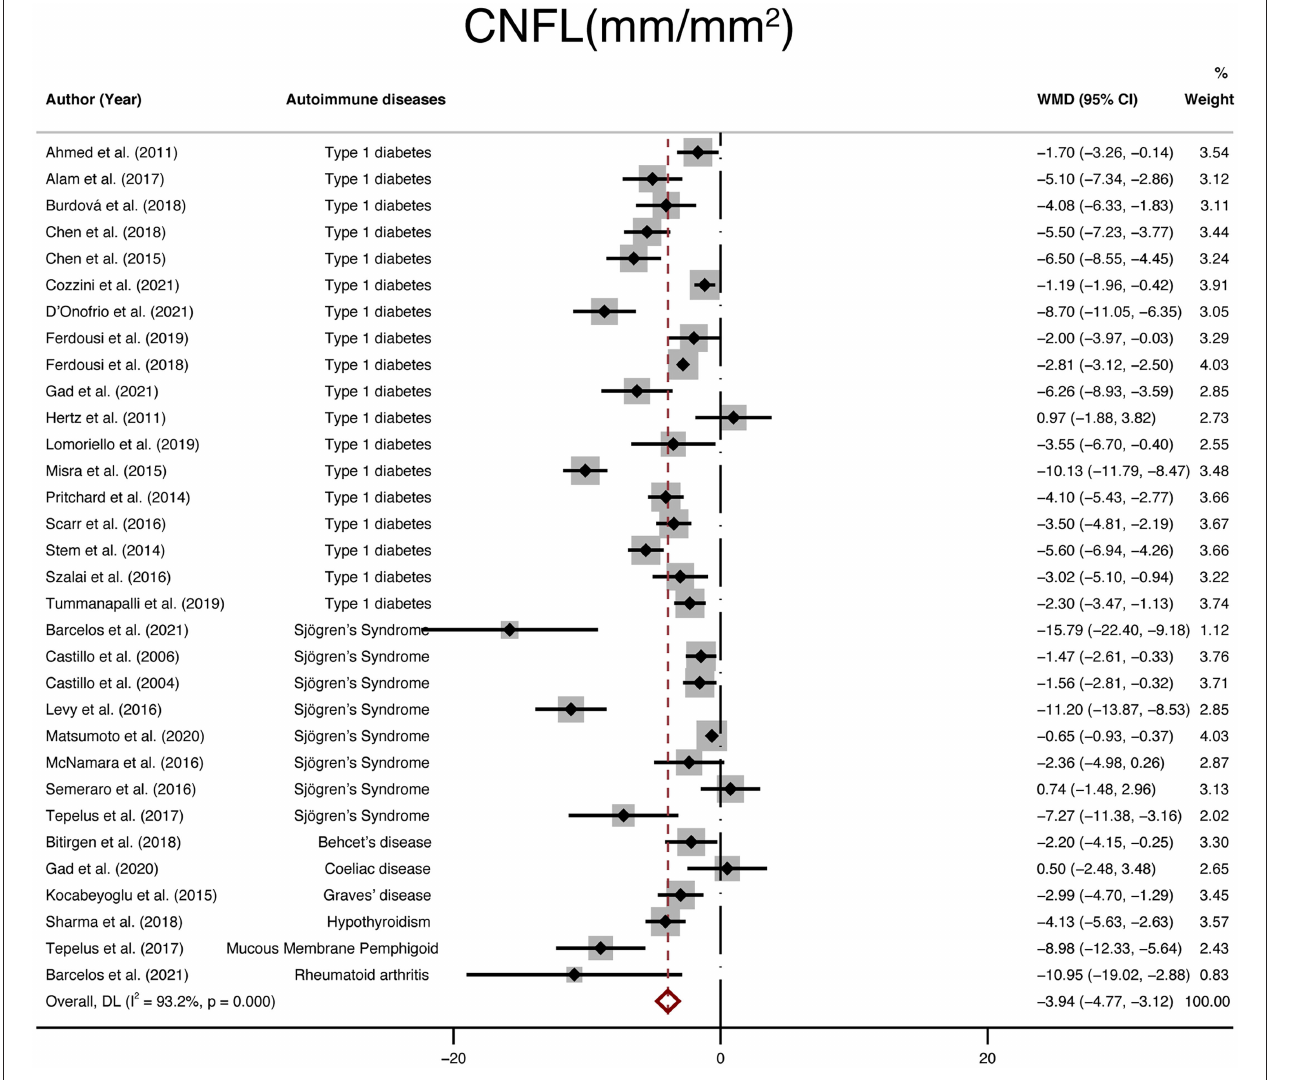
FIGURE 4 | Forest plot of the WMD of CNFL between the NNAI group and the control group. WMD, weighted mean difference; CI, confidence interval; CNFL, corneal nerve fiber length; NNAI, non-neurological autoimmune (diseases).